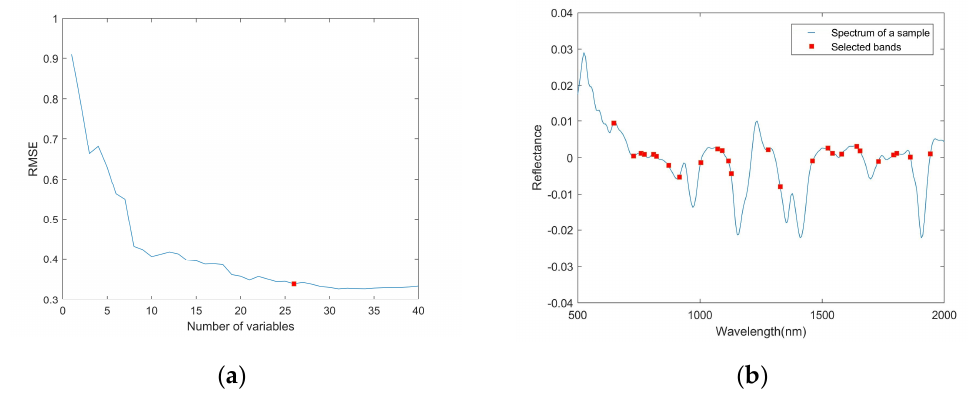
Figure 5. RMSE plot ( a ) and the selected variables for model ( b ) by SPA.